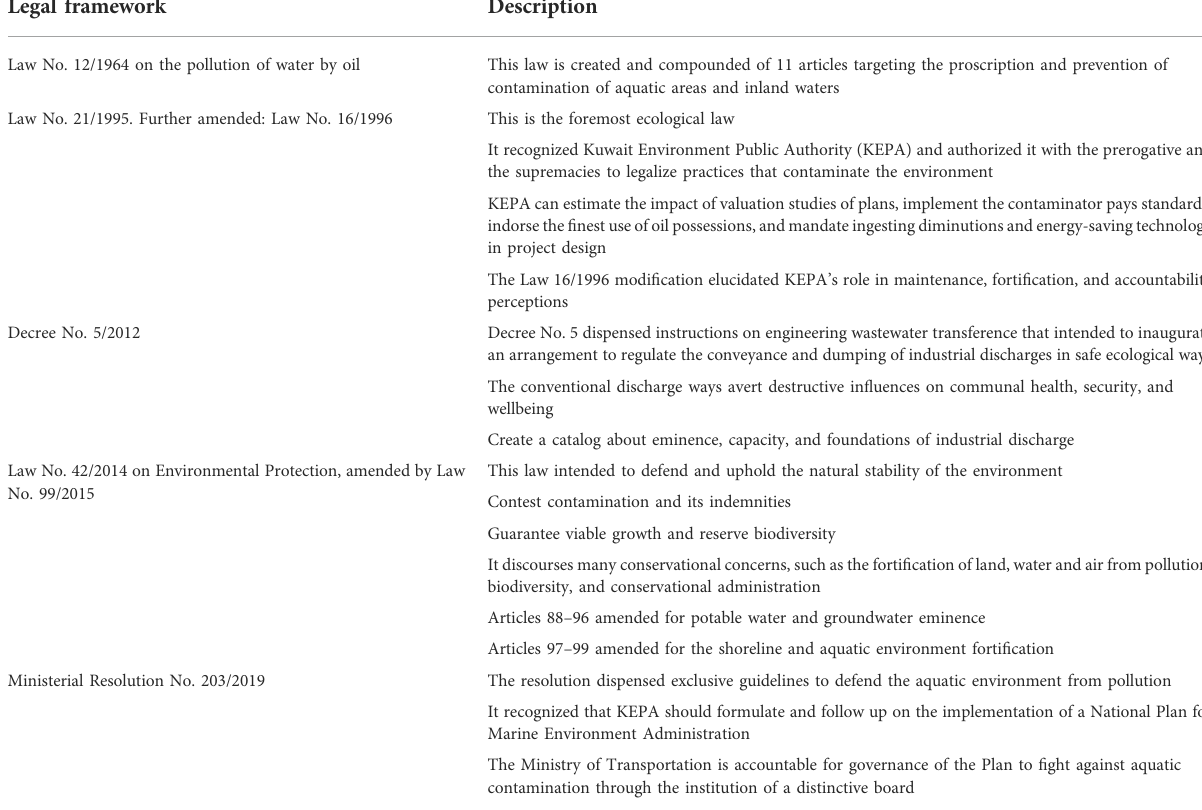
TABLE 5 Legal frameworks and description.